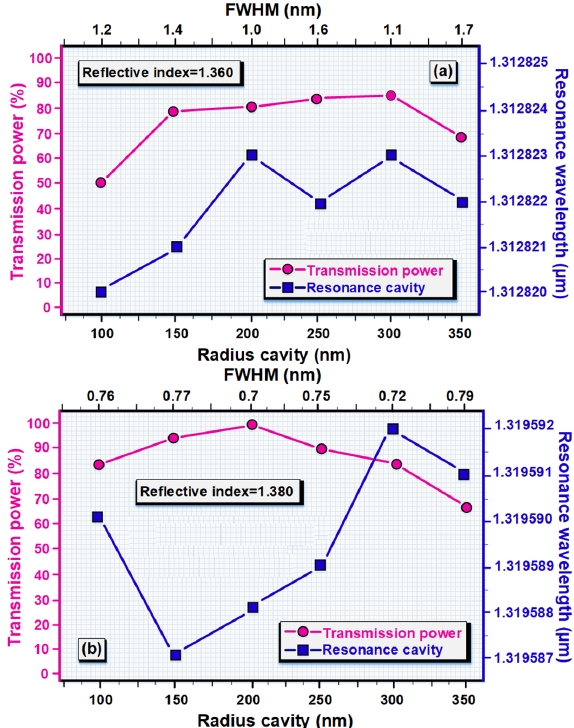
Figure 5. Calculation of the resonant wave-lengths as well as transmission power for several radius cavities, ( a ) for refractive index 1.36, ( b ) for refractive index 1.38.